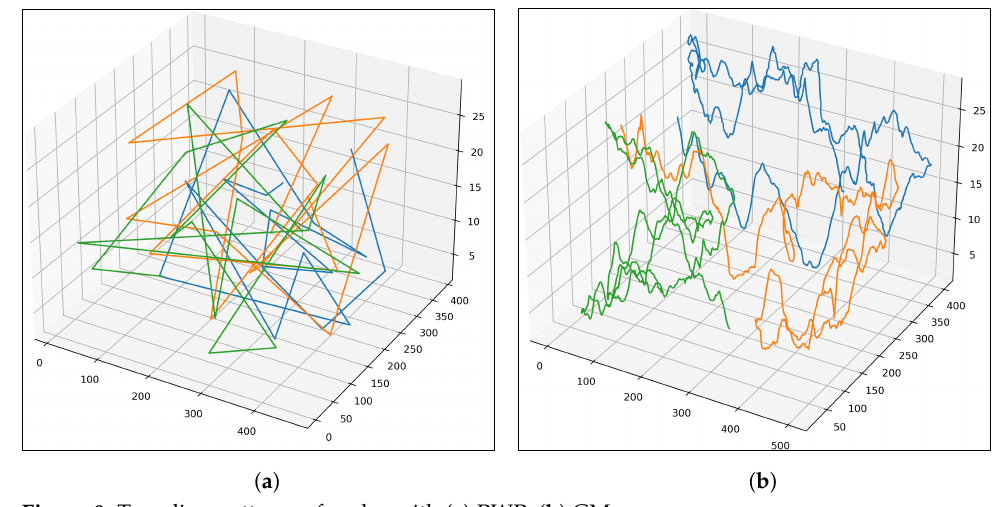
Figure 8. Traveling patterns of nodes with ( a ) RWP; ( b )